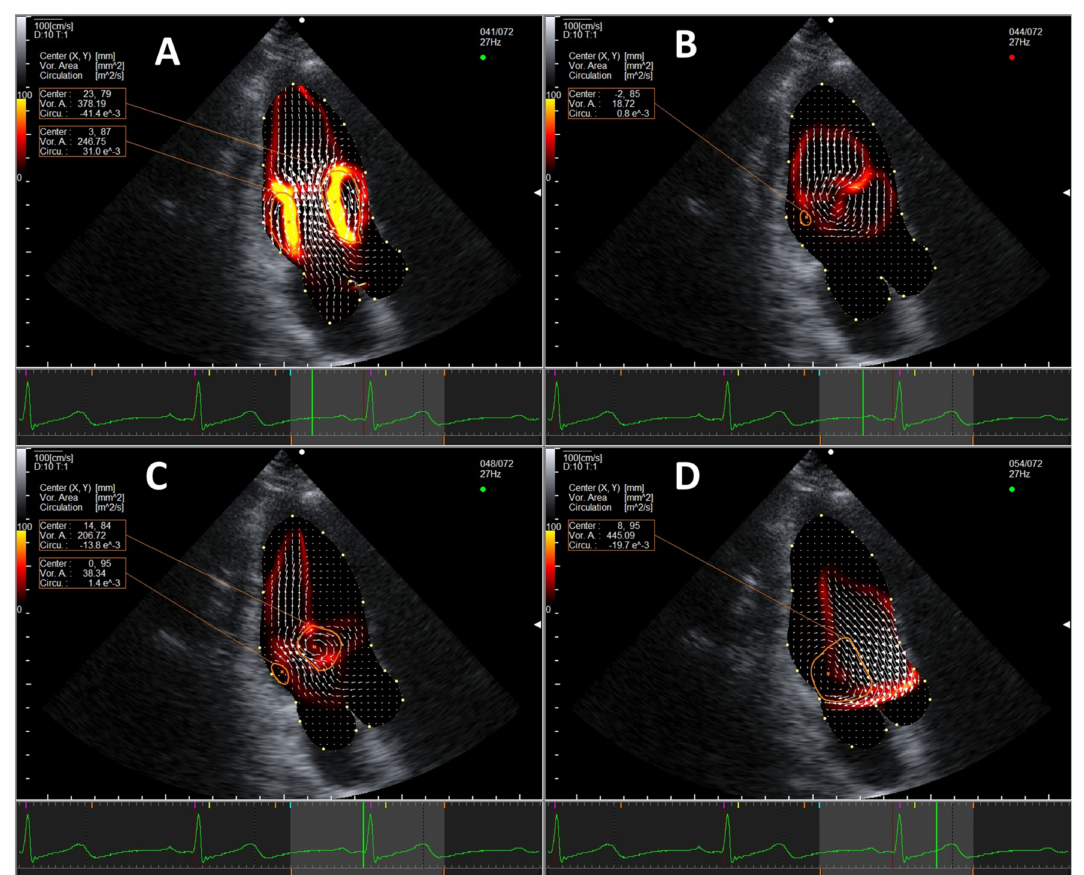
Figure 1. Representative example of normal vortex formation pattern in the apical three-chamber view during ( A ) early diastole, ( B ) at the completion of passive ventricular filling, ( C ) during late diastole, and ( D ) during systole. Vortices are marked in orange circles. An energy loss heat map is displayed under the velocity vectors (white arrows), with red being low energy loss and yellow being